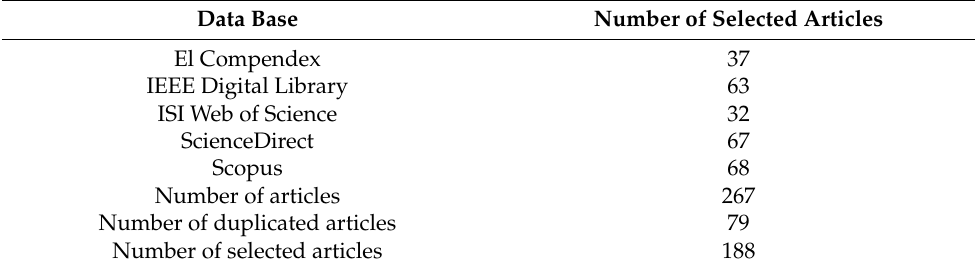
Table 3. Number of selected articles from each